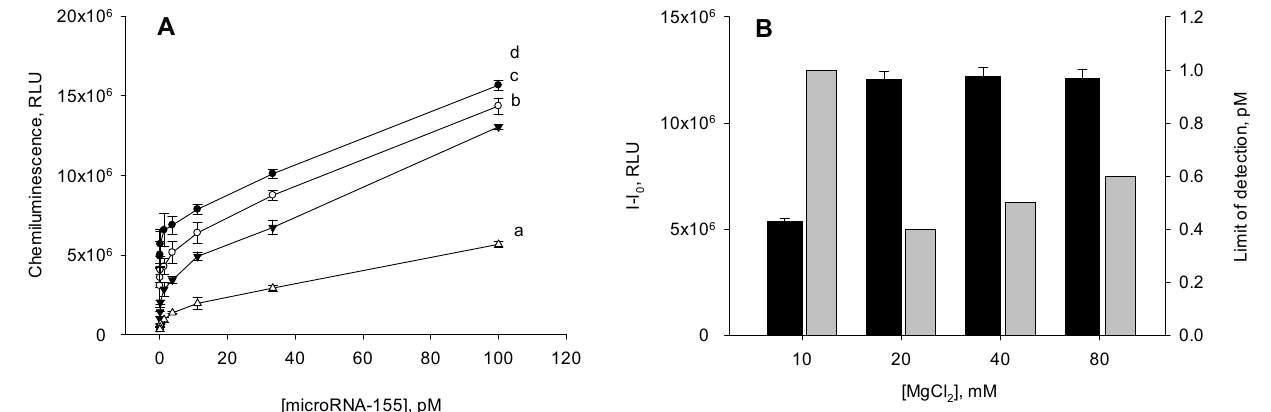
Figure 5. Effect of the MgCl 2 concentration in the reaction solution at the stage of the mismatched catalytic hairpin assembly reaction (mCHA) amplification on ( A ) the behavior of the calibration curves constructed, ( B ) chemiluminescence signal (I–I 0 ) (black columns), and limit of detection (gray columns) of the amplified microRNA-155 assay. The mCHA reaction was carried out at 25°C for 1 h using the 160 nM B-HP2 probe in 10 mM Tris-HCl with pH 7.2 containing MgCl 2 concentrations of (a) 10, (b) 20, (c) 40, and (d) 80 mM. The value of the chemiluminescence signal (I–I 0 ) was calculated as the difference between the chemiluminescence intensities recorded in the presence (100 pM) and in the absence of the microRNA-155. The detection limit was calculated based on the 3 σ rule.